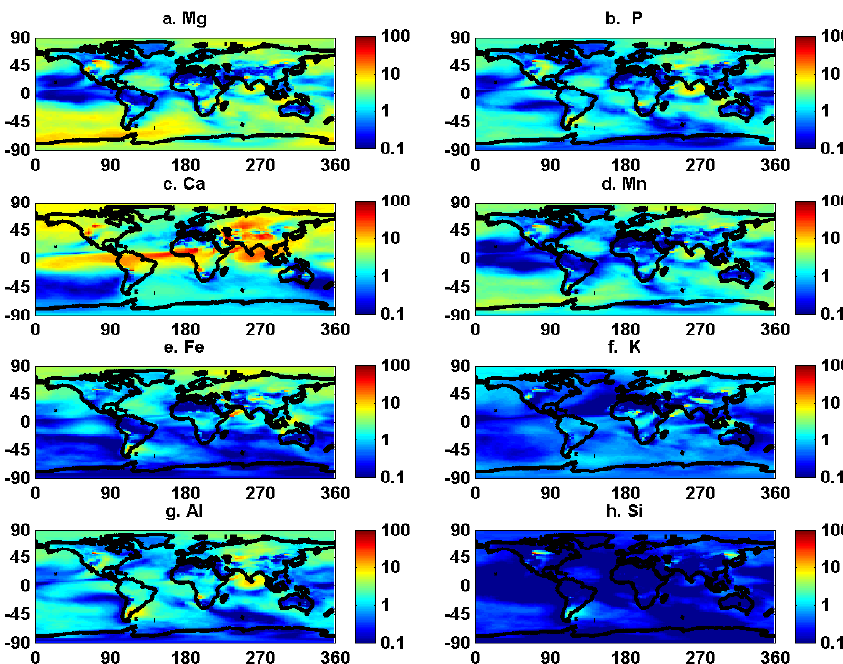
Figure 6. Ten-year monthly variability in mean of elemental percentages in atmospheric dust (mass %): (a) Mg, (b) P, (c) Ca, (d) Mn, (e) Fe, (f) K, (g) Al, (h) Si. Elemental monthly mean percentages are calculated using the monthly mean emission of each element divided by the monthly mean emission of dust.